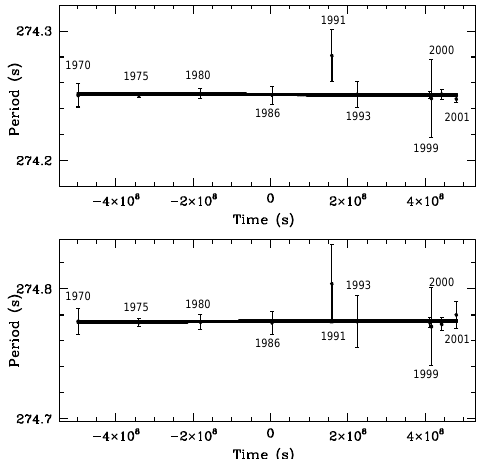
Fig. 3. Direct method: a plot of the best seasonal periods vs time for the 274 s doublet. The top panel shows the best fit ˙ P = (-10.0 ± 8.8) × 10 − 13 s/s for P = 274.2511 ± 0.0003 s, while the lower panel indicates the best fit ˙ P 0 = 274.7751 ± 0.0003 = (8.8 ± 9.1) × 10 − 13 s/s for P 0